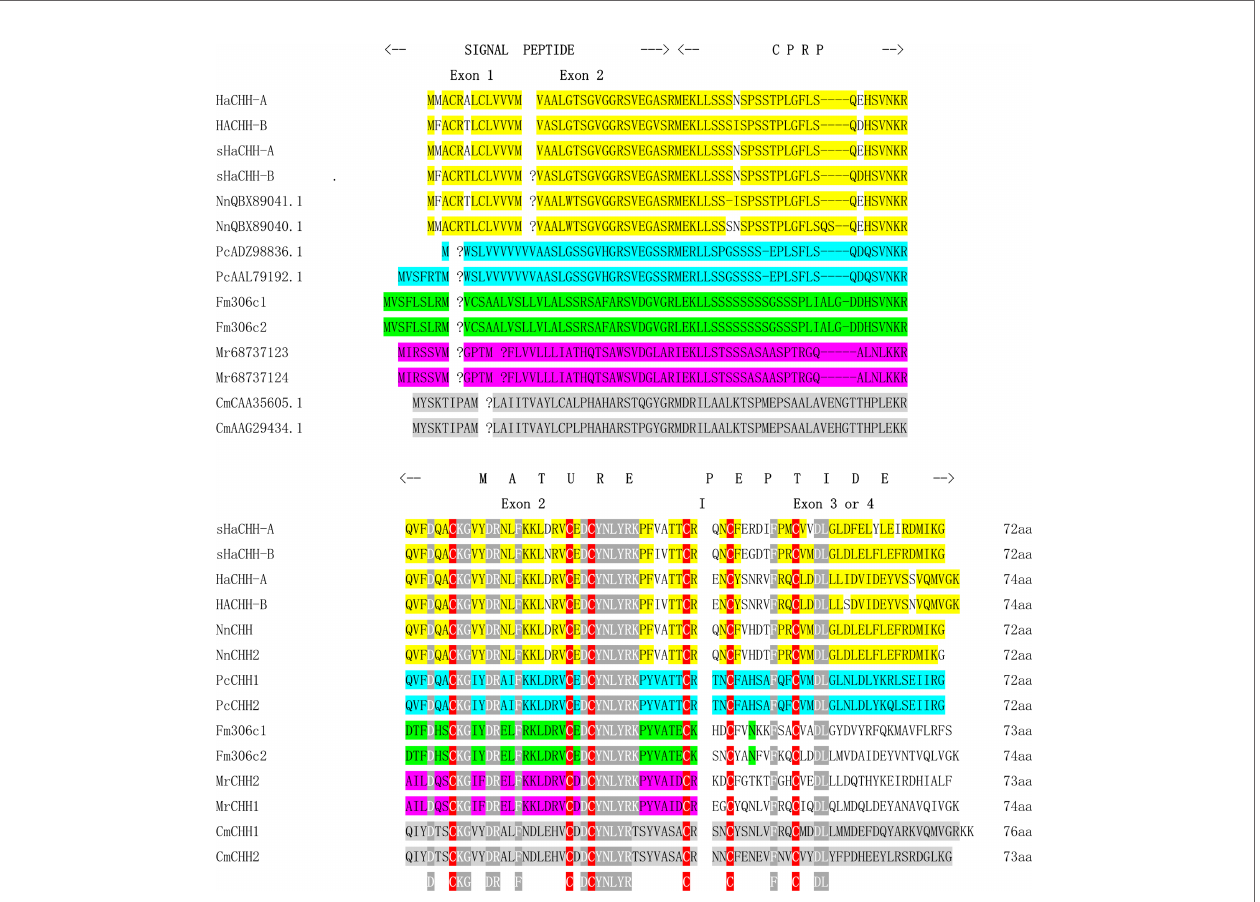
FIGURE 4 | Alignment of the lobster four-exon CHH genes with that of other decapods, including lobster ( yellow : HaCHH-A and HaCHH-B ; NnCHH-1 and NnCHH- 2 ), crab ( gray : CmCHH-1 and CmCHH2 ), shrimp ( green : Fm306-c1 and Fm306-c2 ) (Shi et al., 2018), freshwater shrimp ( pink : MrCHH1 and MrCHH2 ), and cray fi sh ( blue : PcCHH1 , PcCHH2 ). The same block color indicates the same groups of decapods. Signal peptides and mature peptides are indicated. Gaps are introduced in the boundary of the exons in lobster, shrimp, and crab CHH-like genes. A question mark is inserted in the locations of potential intron insertion sites in the CHH-like genes from other decapods. In addition to the conserved cysteine residues ( highlighted in red ), several conserved amino acids ( highlighted in gray ) may be important for motif structure formation of the